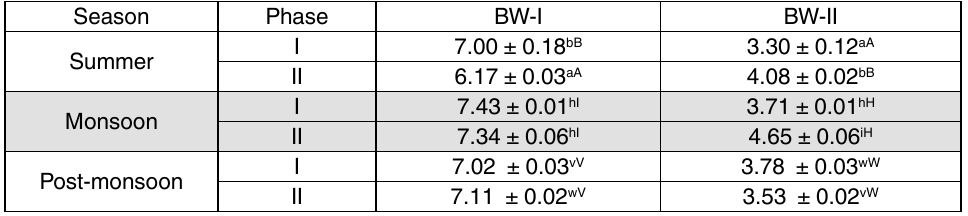
Table 2. pH of poultry slaughter waste and food waste leachate